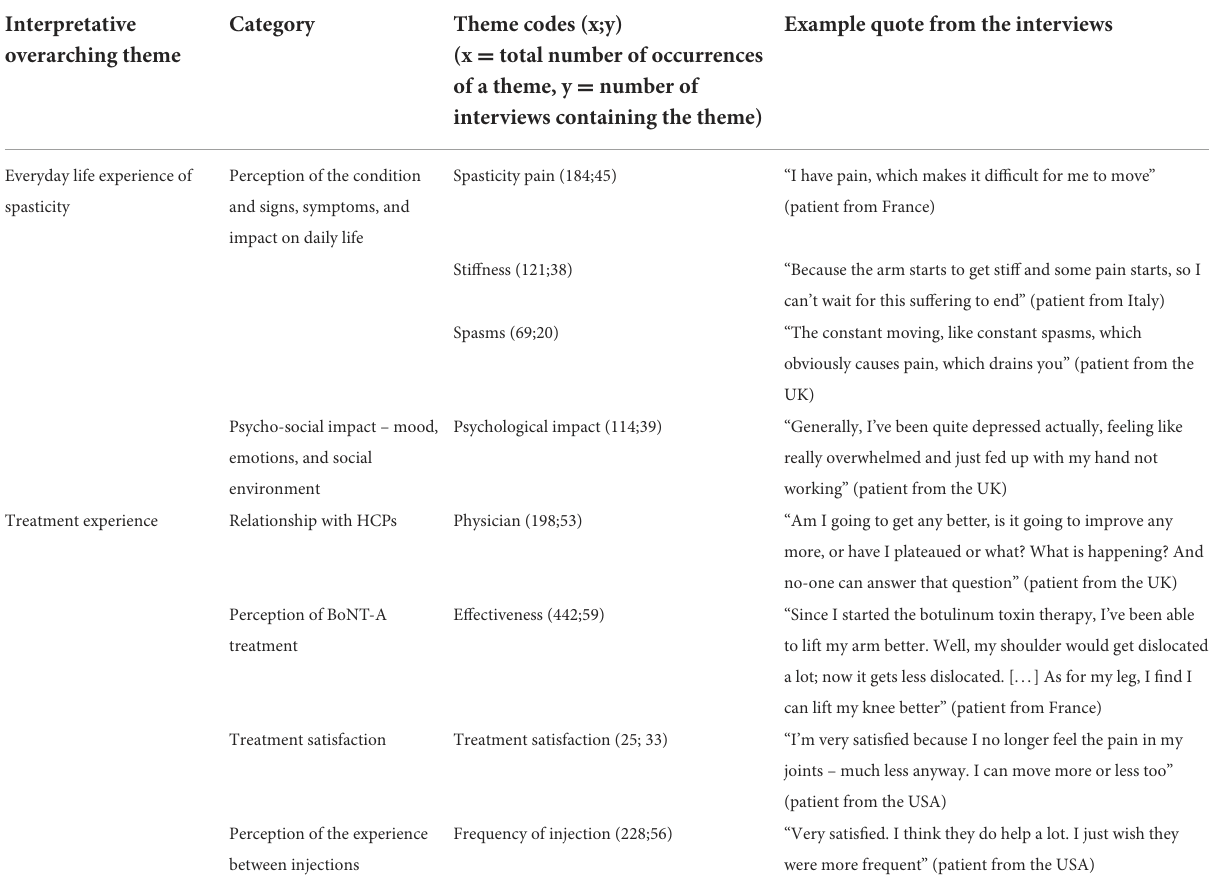
TABLE 2 Frequently recurring themes identified during the interviews (stages 1 and 3 of the study). Interpretative overarching